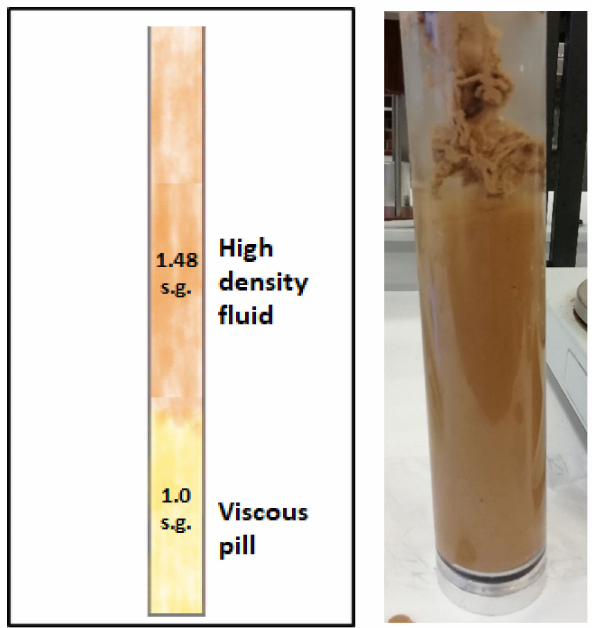
Figure 4. Illustration of the benchtop experiments and the result of the test with viscous Pill